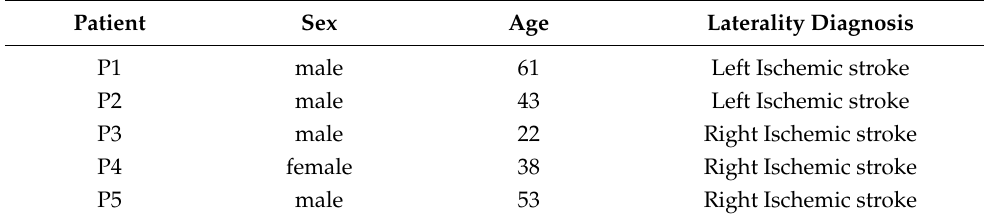
Table 2. Demographic and clinical characteristics of